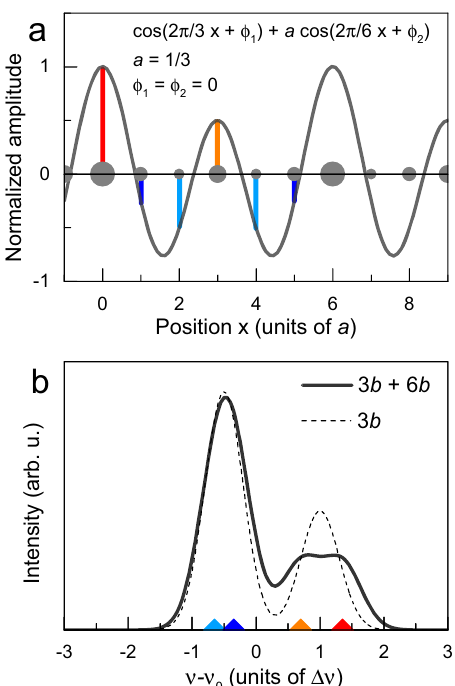
Fig. 5 Testing the PDW hypothesis. a Sum of uniaxial modulations with periods 3 b and 6 b and equal phases ϕ 1 = ϕ 2 = 0. The 6 b modulation has amplitude a = 1/3. The maximal amplitude is 4/3 but the scale has been normalised by this value. b Corresponding histogram for the modulation in panel ( a ). The 3 b + 6 b modulation (continuous line) shifts each of the two contributions in the 3 b histogram (dashed line)